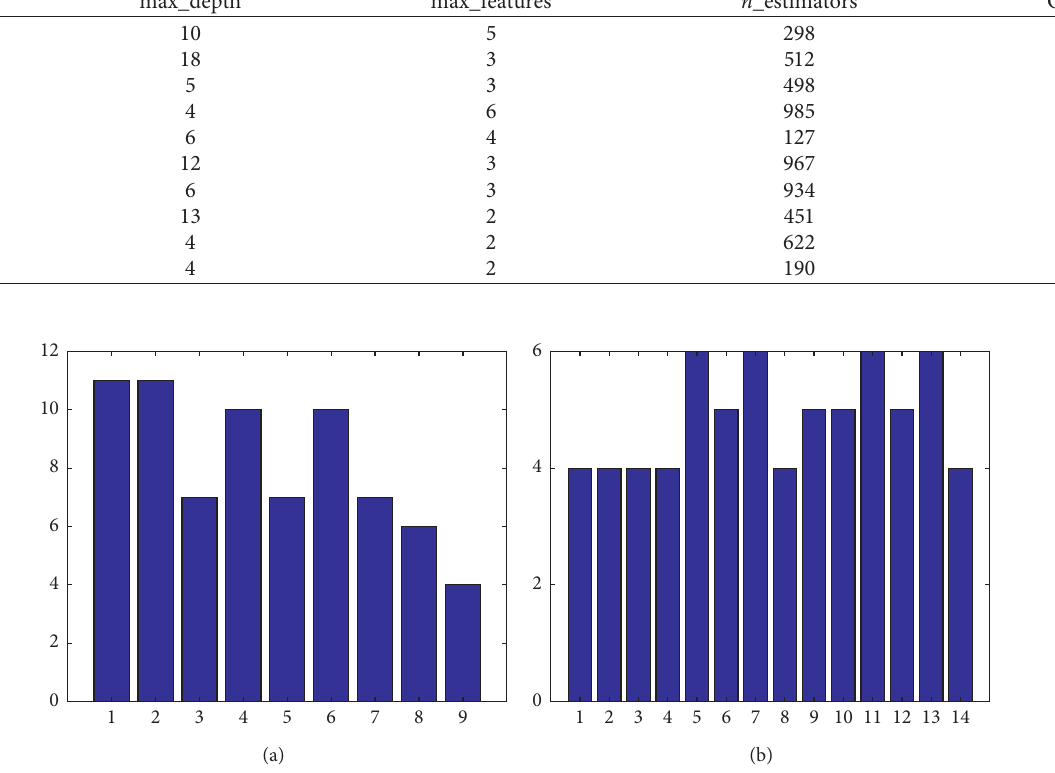
Figure 7: The size of selected PC for (a) each GCM and MME:1–8 denote the GCM number, and 9 is MME; (b) BMA for each station:1–14 denote station